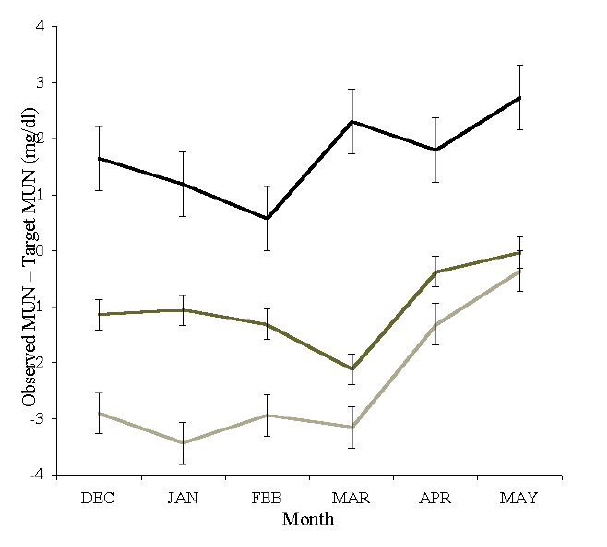
FIGURE 3. Monthly MUN minus target MUN for dairy farms that reported decreasing dietary crude protein (top line), increasing dietary crude protein (bottom line), or not changing dietary crude protein (middle